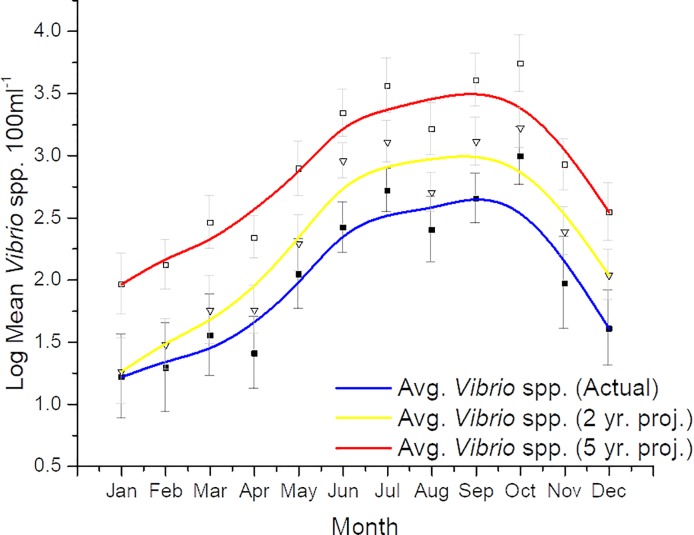
10-year monthly average Vibrio spp. abundance (symbols) and 3-month moving average (lines) during the study (blue line), and 2 (yellow line) and 5 (red line) years beyond the study.Error bars are standard error of the means.